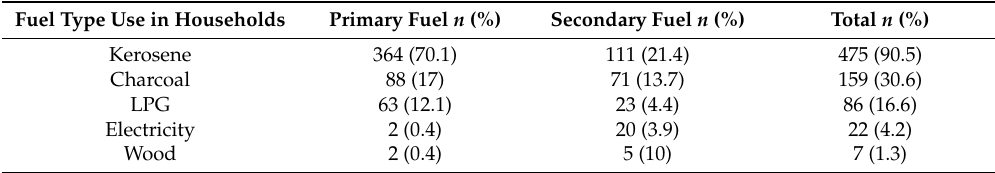
Table 2. Choice of primary and secondary household cooking fuels.